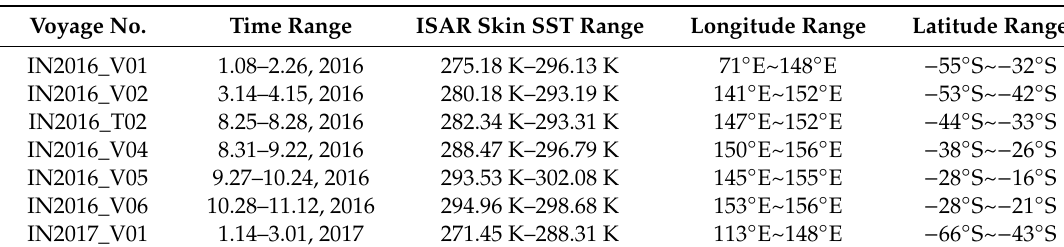
Table 1. Details of the research vessel (RV) Investigator’s Infrared sea surface temperature (SST) Autonomous Radiometer (ISAR) cruises.